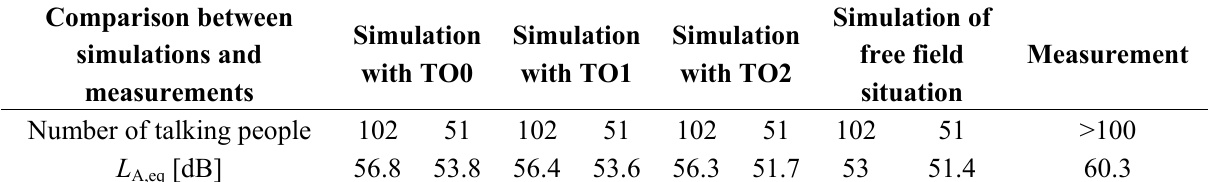
Table 1. Values of L for different numbers of speaking people: comparison between A,eq simulations and measurements in situ